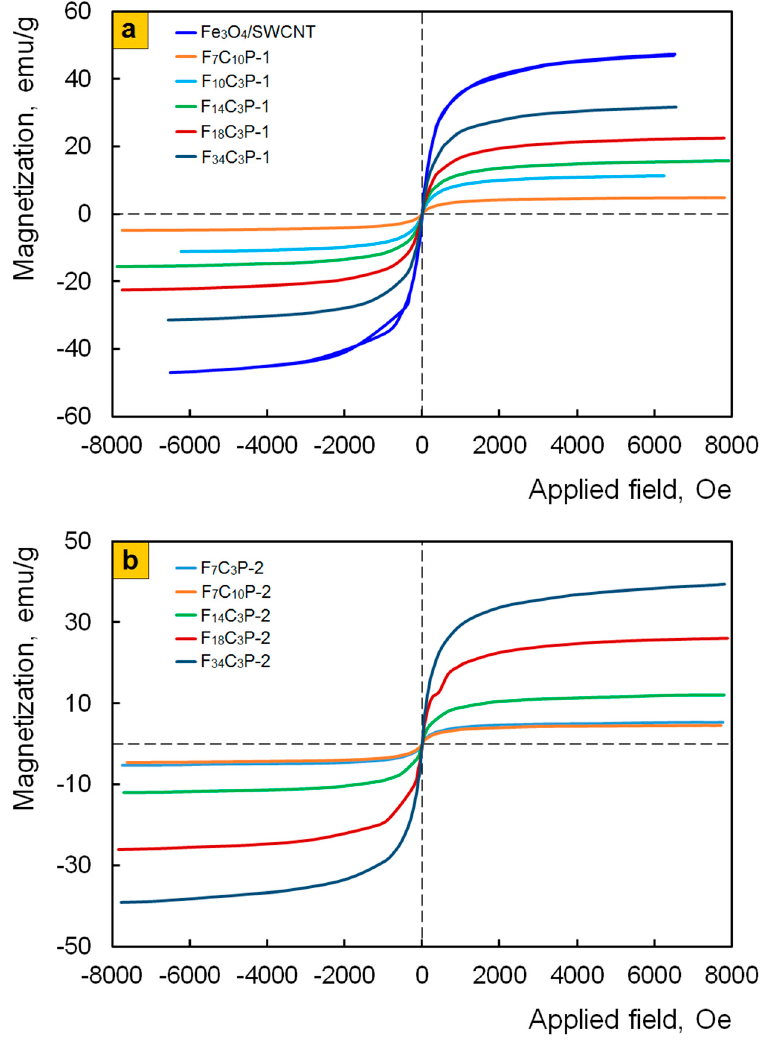
Figure 12. Magnetization of Fe 3 O 4 / SWCNT and Fe 3 O 4 / SWCNT / PDPAC, prepared in alkaline ( a ) and acidic media ( b ), as a function of applied magnetic field at room temperature.